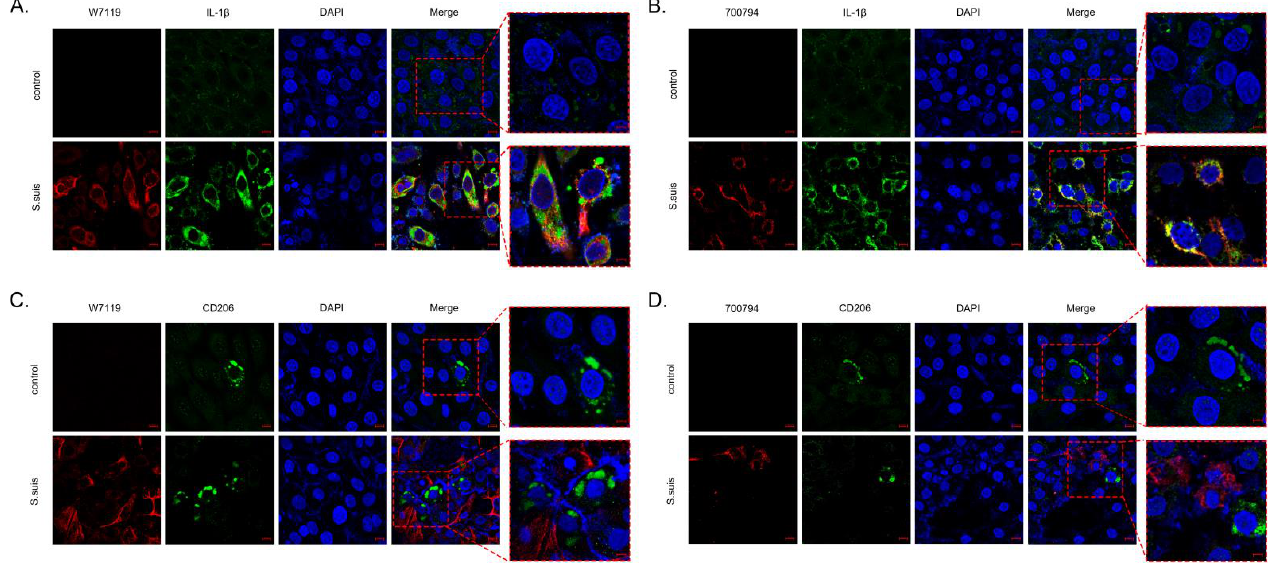
Figure 3. Confocal laser scanning microscopy images of S. suis inducing PAM-Tang polarization. PAM-Tang cells were infected by S. Suis vir-700794 or S. suis avir-W7119 (MOI = 1) and stained with anti- S. suis antibody (red), M1 macrophage marker IL-1 β antibody (green) in ( A , B ), or M2 macrophage marker CD206 antibody (green) in ( C , D ). Nuclei were stained by DAPI